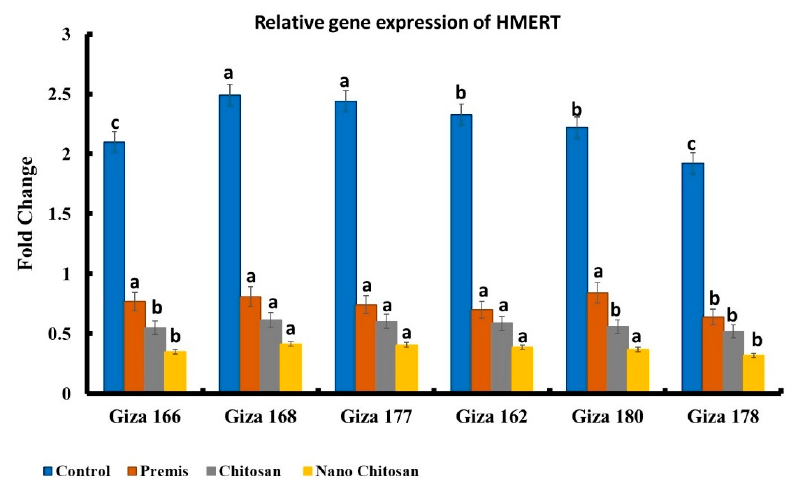
Figure 9. Relative gene expression values of H. maydis AFLP-derived species-specific fragment, utilizing A200a primer set against the housekeeping gene of the mitochondria-cytochrome c oxidase, COXI gene. a,b,c Estimates with the same letters are not significantly different ( p < 0.05).